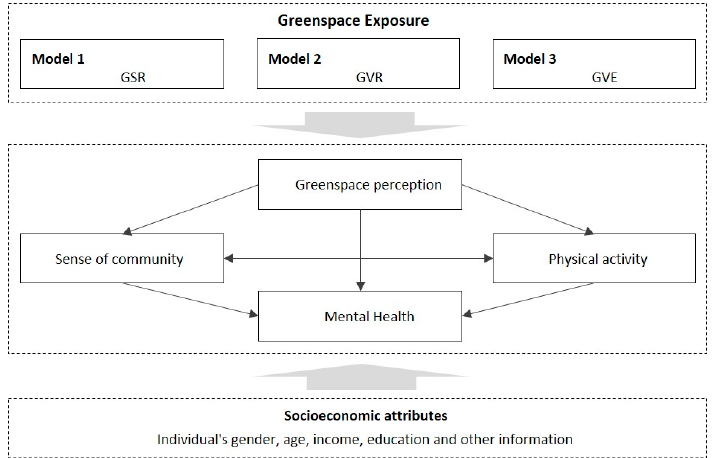
Figure 3. Empirical research method.